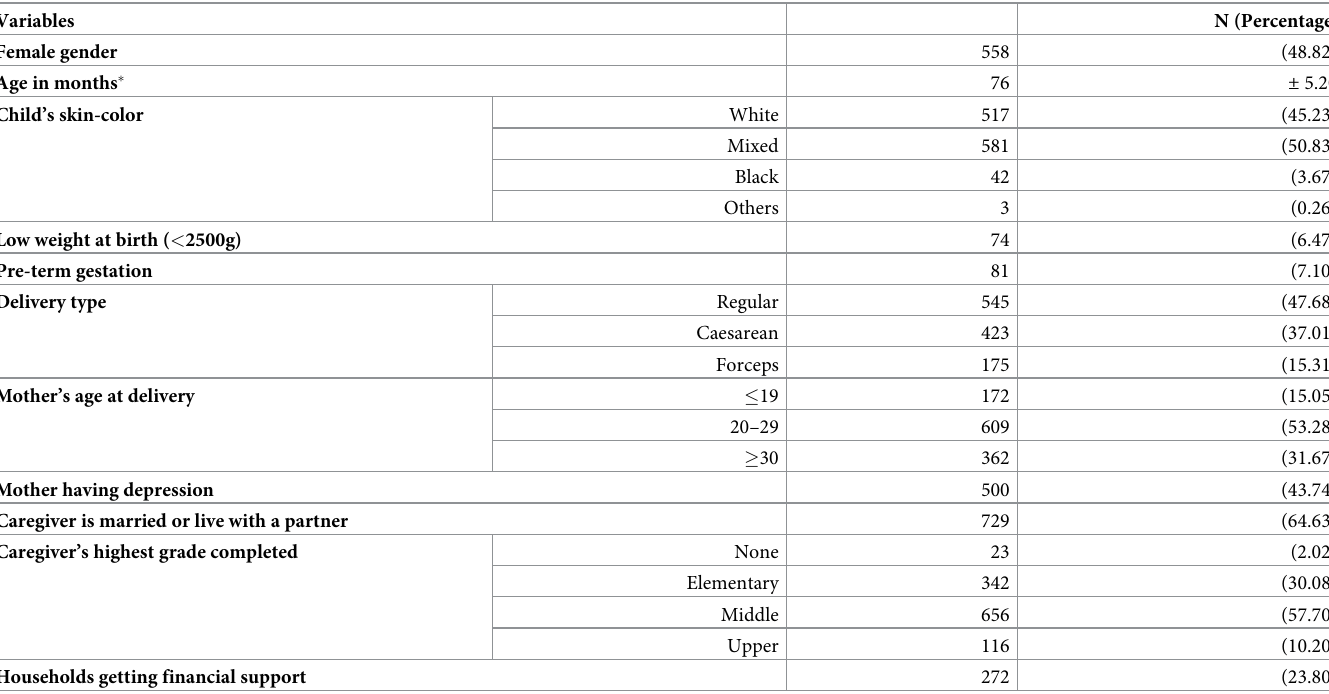
Table 1. Participants’